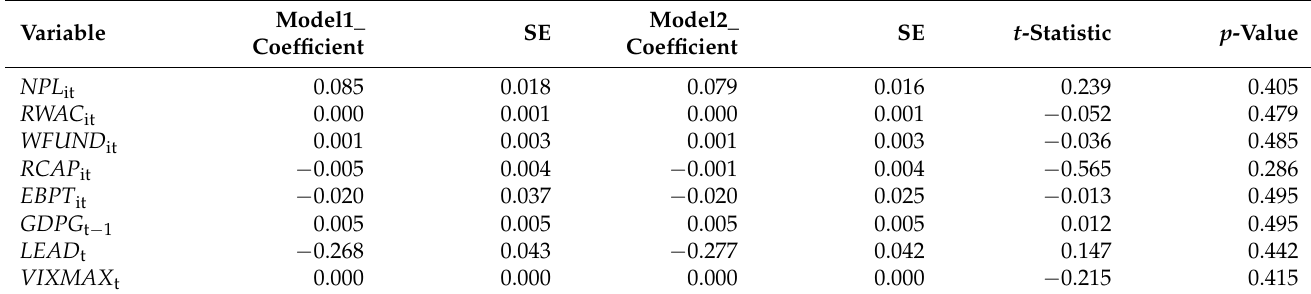
Table A3. Comparison of post-crisis (5) and post-crisis (adjusted) (6).